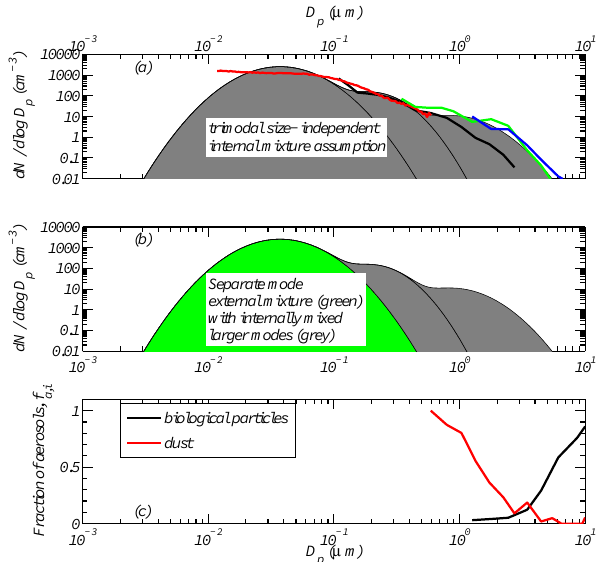
Fig. 6. (a) the ground based and aircraft (run R2, below cloud) aerosol size distribution measurements. Red line: SMPS (ground); Black line: PCASP (aircraft); Green line: GRIMM (ground); Blue line: WIBS total (ground). Note that in some of the ACPIM runs we assumed that the aerosols had size independent composition (as shown in a) and in other runs that the aerosol had a small mode of non-hygroscopic organic aerosols (as shown in b ). (c) the frac- tion of aerosols measured by the WIBS and determined to be of biological origin (black line), and the fraction of the filter sam- ple derived aerosol size distribution (determined from ESEM/EDX analysis of samples) that was refractory in nature (red line). The three lognormal modes that were fitted to the data have fit pa- rameters: n = [3221 , 145 , 13 . 7] cm − 3 ; ¯ d = [37 , 200 , 861] nm and ln σ g = [0 . 50 , 0 . 40 , 0 .